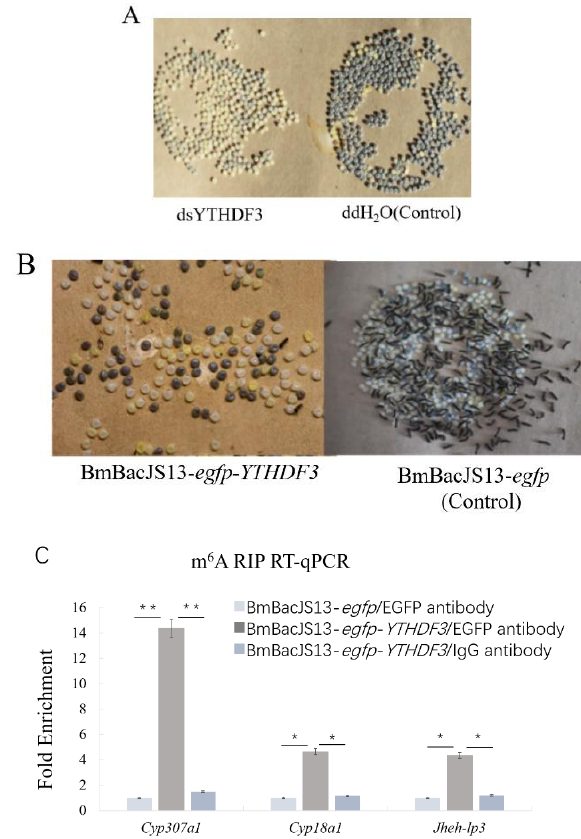
Figure 2. YTHDF3 regulates B. mori diapause. (A ) Silkworm egg development is delayed after YTHDF3 knockdown; ( B ) Overexpression of YTHDF3 induces diapause; ( C ) After